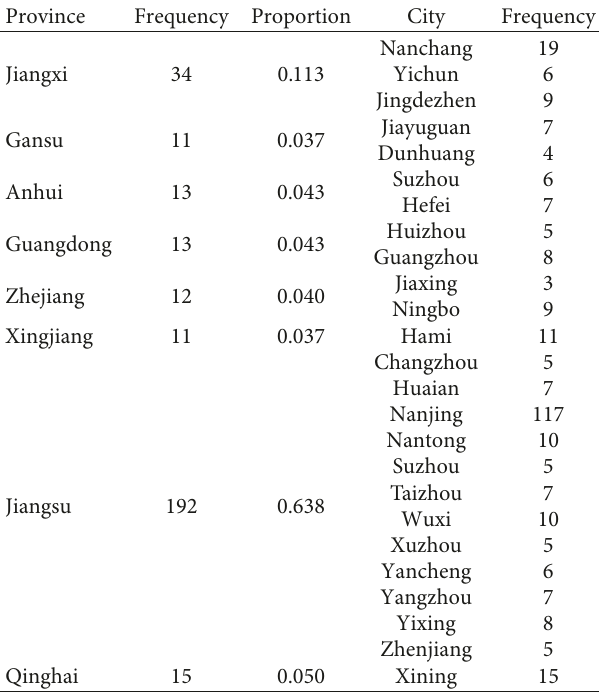
Table 5: Characteristics of province and region sampled offline. Province Frequency